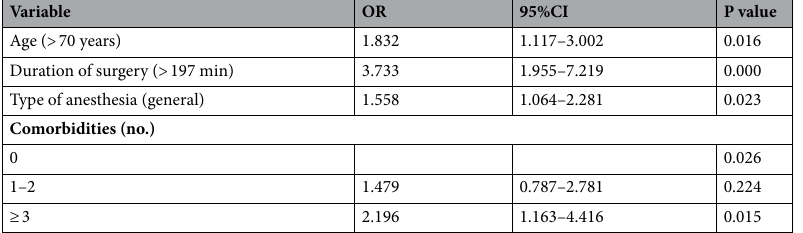
Table 5. OR, 95% CI, and P value for independent risk factors in the multivariable logistic regression analysis of PNO-DVT. OR odds radio, CI confidence interval, CKMB creatine phosphokinase isoenzyme, BNP brain natriuretic